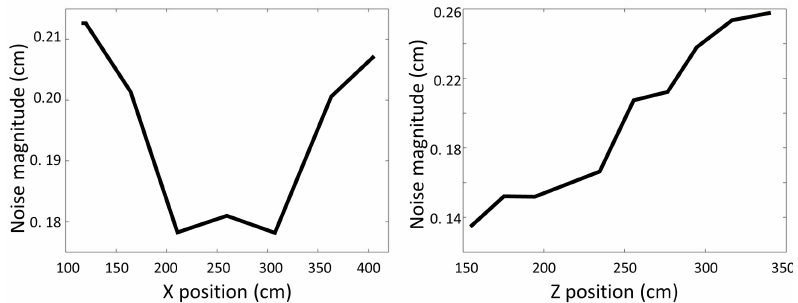
Figure 7. Noise magnitude as a function of horizontal position (X pos) ( left ) and depth (Z-pos) ( right ). Noise increases with horizontal distance from center and increases with depth (distance from